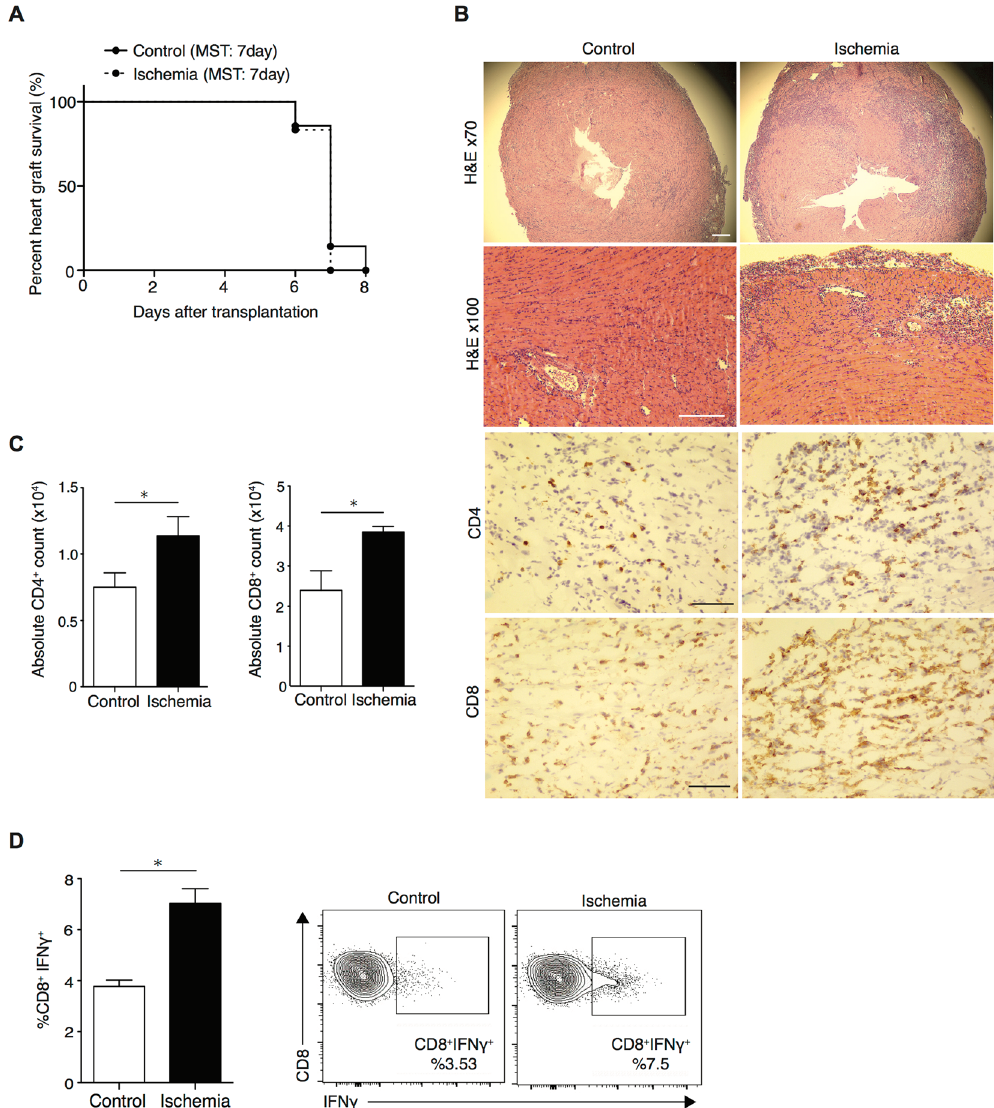
Figure 1. Ischemia is associated with increased graft infiltration and augmentation of the alloimmune response in a complete allo-mismatch model. Full MHC mismatch BALB/c hearts were harvested and transplanted into C57BL/6 recipients within 30 minutes (control group) or after 8 hours stored in UW solution, at 4 °C (ischemic group). Recipients were followed for transplant survival or grafts were harvested at day 6. ( A ) No difference was observed in tempo of graft rejection between control and ischemic group (MST: 7 vs. 7 days, p = 0.3, n = 6–7/group) ( B ) Histological analysis at 6 days post-transplant showed increased tissue injury and increased CD4 + and CD8 + T cell infiltration of ischemic heart grafts as compared to controls. (Scale bar 100 μ m for H&E stain, 50 μ m for CD4 and CD8 stain). ( C ) Enumeration of absolute number of cardiac graft-infiltrating cells, as assessed by flow cytometry of control and ischemic grafts, revealed a greater number of CD4 + and CD8 + infiltrating ischemic grafts (7.5 × 10 3 ± 1 × 10 3 vs. 12.6 × 10 3 ± 1.2 × 10 3 , * p < 0.05 for CD4 + T cells and 24 × 10 3 ± 4.8 × 10 3 vs. 38.5 × 10 3 ± 1.4 × 10 3 , * p < 0.05 for CD8 + T cells, respectively, n = 3/group). ( D ) A marked increase in the frequency of IFN γ -producing CD8 + T cell in ischemic grafts as compared to controls (7.0 ± 0.5% vs. 3.7 ± 0.2%, * p < 0.05, respectively, n = 3/group). Representative flow plots, gating on CD8 + T